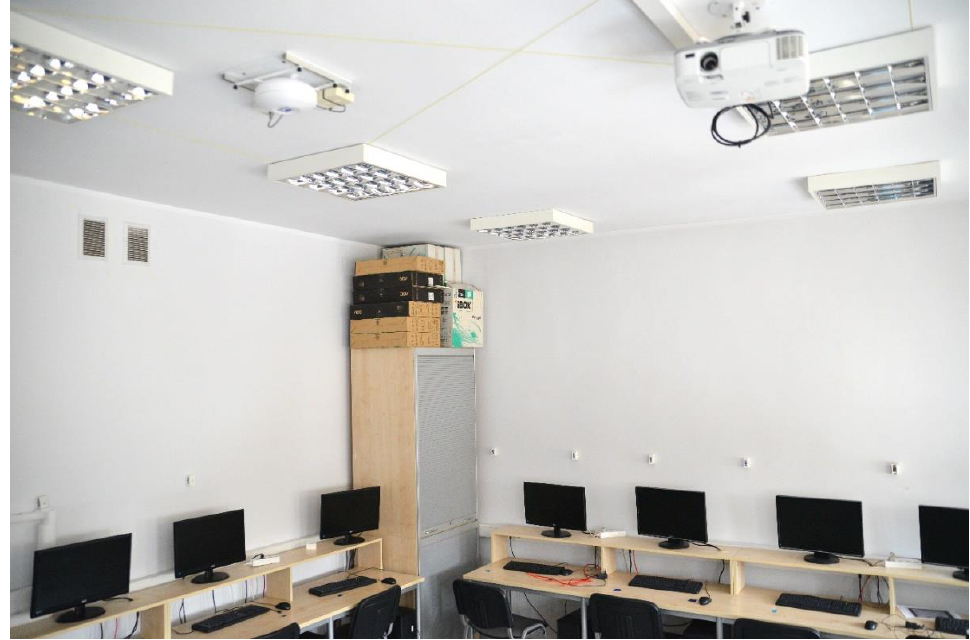
Figure 7. Test environment with reference nodes installed on the walls and the ESPAR antenna integrated with the custom-made WSN board in a single housing mounted on the ceiling.